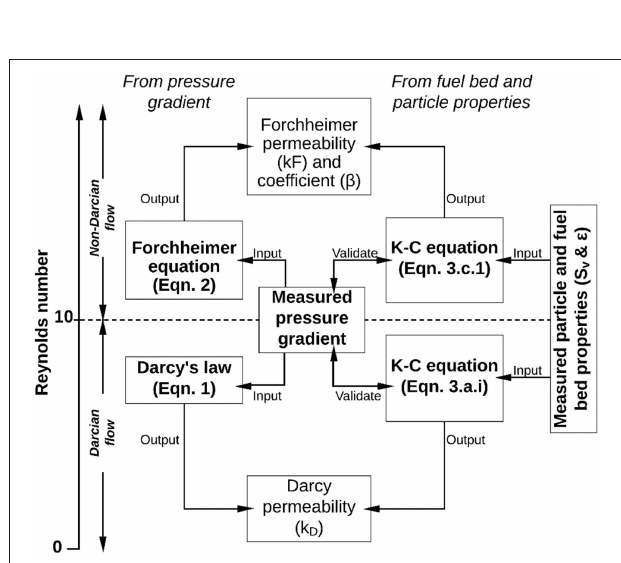
FIGURE 3 | Schematic diagram for determining the air permeability of a fuel